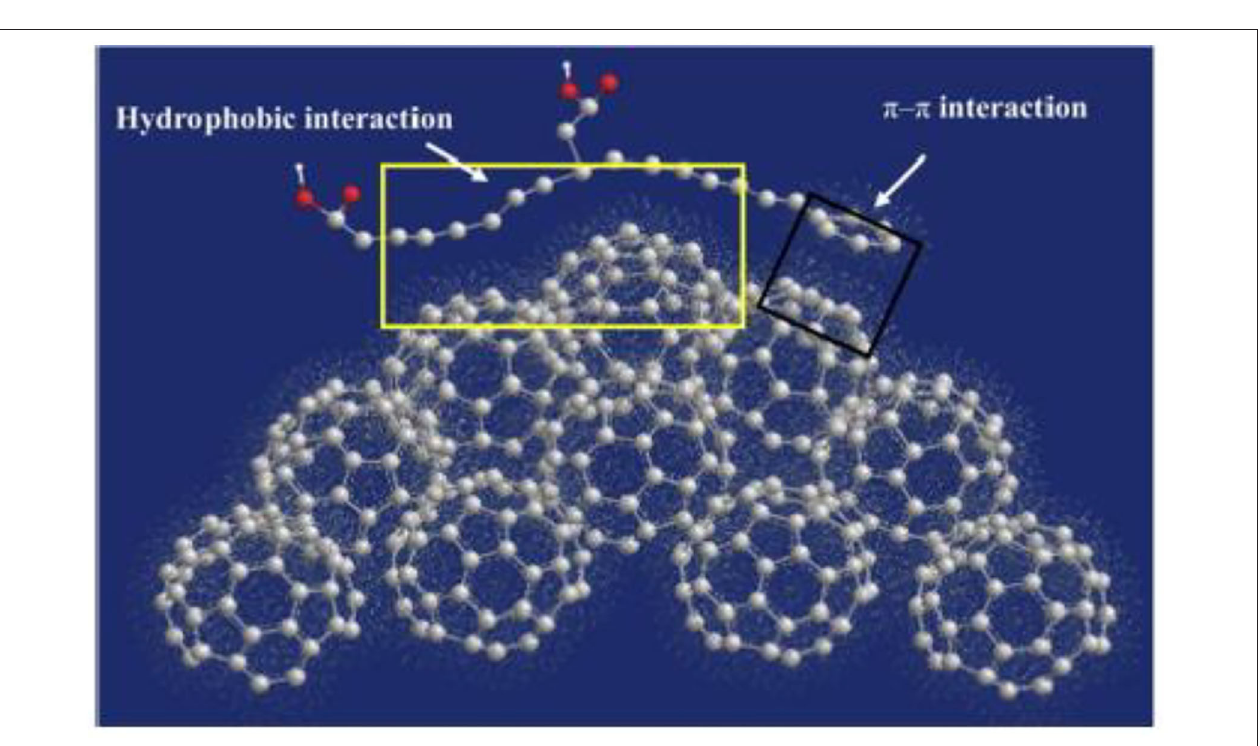
FIGURE 7 | A snapshot of the interaction between a small humic substance molecule and fullerene C 60 (carbon, gray; oxygen, red). (Wu et al.,